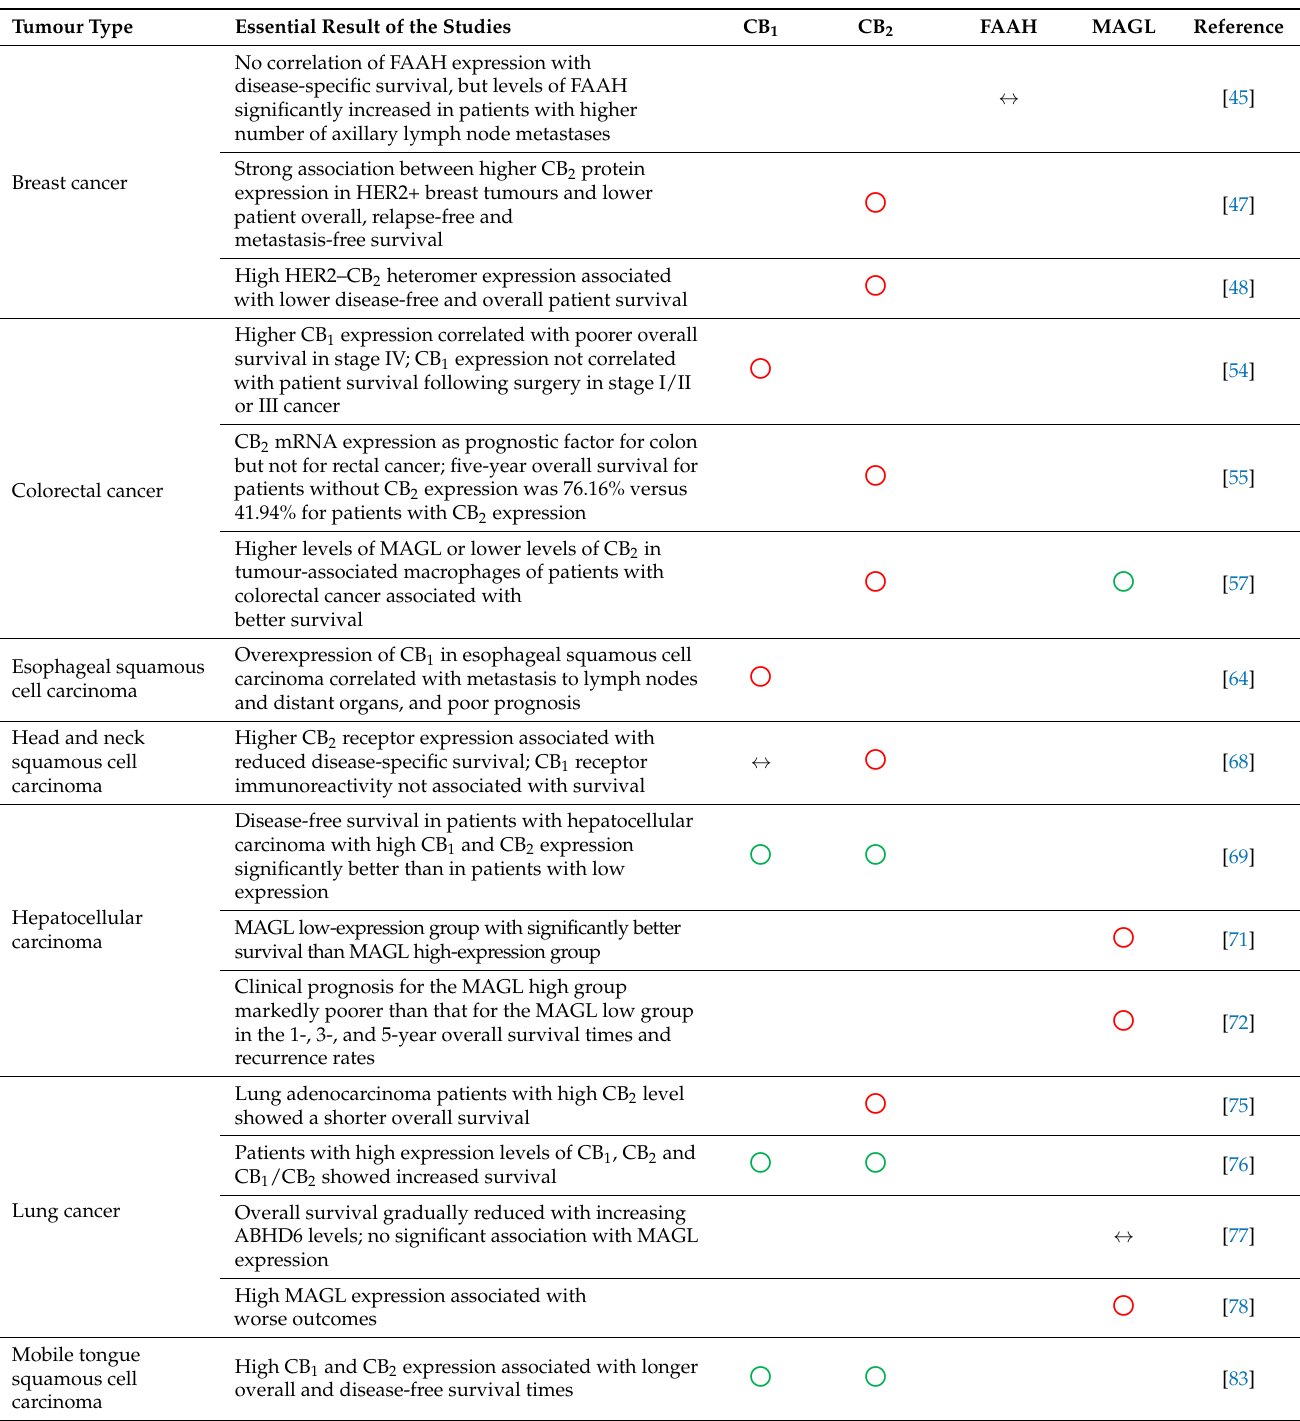
Cancers 2021 , 13 , x FOR PEER Table 2. Relationship between expression levels of cannabinoid receptors, FAAH and MAGL and patient survival. Tumour Type